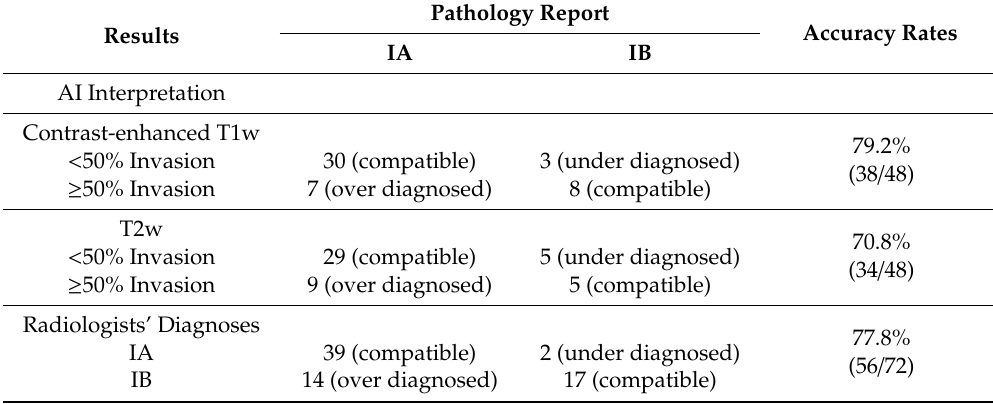
Table 3. Influence of concomitant conditions on the accuracy rates of AI and radiologists.